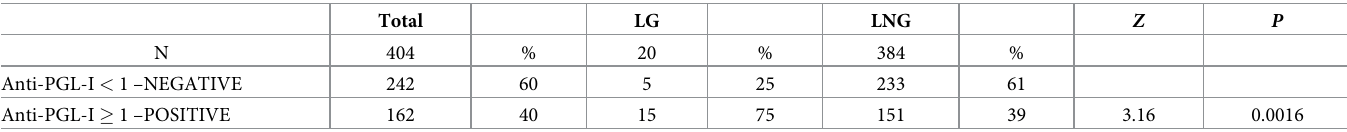
Table 7. Results of measurements of anti-PGL-I antibodies among women tested at the Ribeir ã o Preto Female Prison (n =